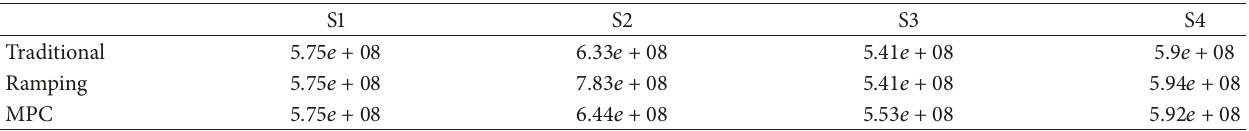
Table 4: Economic cost comparison of the